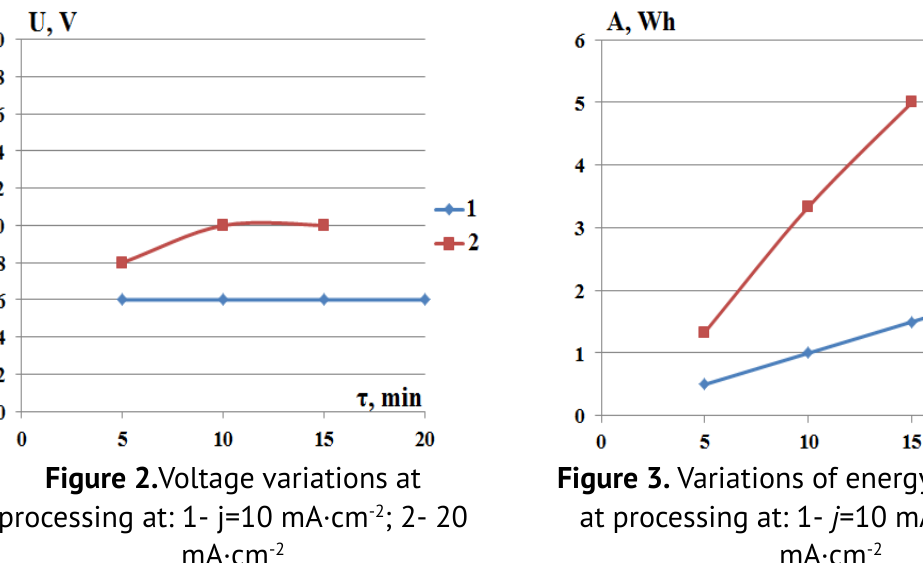
Figure 2. Voltage variations at processing at: 1- j=10 mA·cm -2 ; 2- 20 mA·cm -2